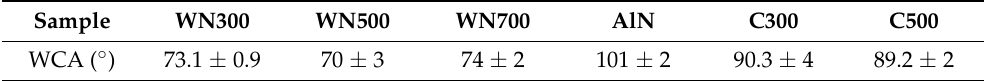
by a droplet of two liquids, polar and nonpolar (water and di ‐ iodomethane), on the solid Table 3. Water contact angle surface of the samples’ basal plane, surface tension was measured, separating the London